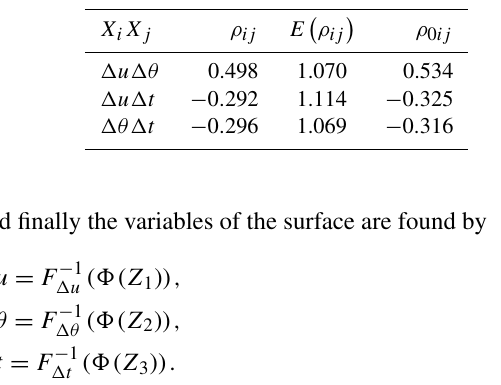
Table 1. The estimated correlation coefficients and the evaluated empirical expressions for E